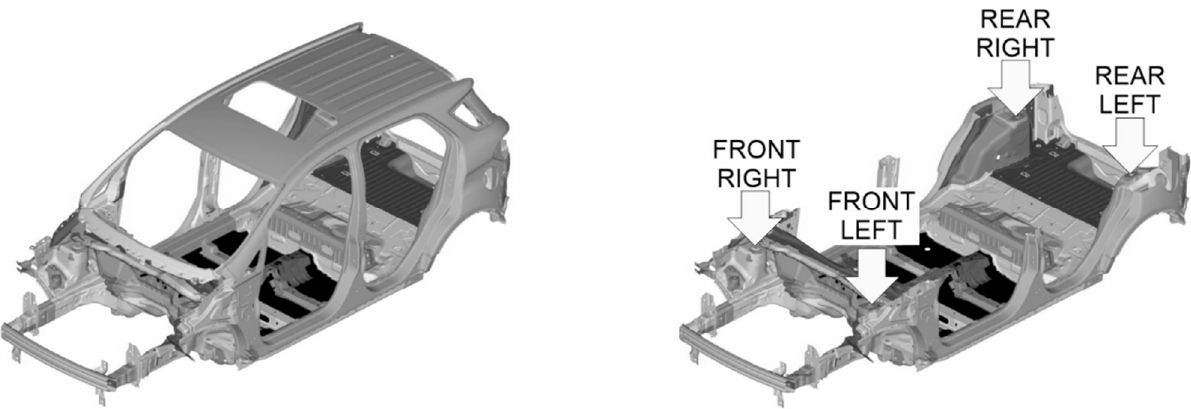
Figure 3. Reference FE model of the vehicle body structure ( left ) and body structure excitation points ( right ).